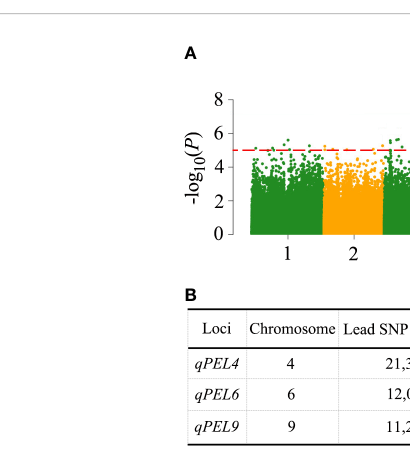
FIGURE 3 QTLs identi fi ed by GWAS in rice. (A) Manhattan plots for the whole population of 353 rice accessions. Negative log10 transformed P-values are plotted on the vertical axis, and dots above the red dashed line show the signi fi cant SNPs in the QTL region. The QTLs identi fi ed are shown by the black arrows. (B) Information about the identi fi ed